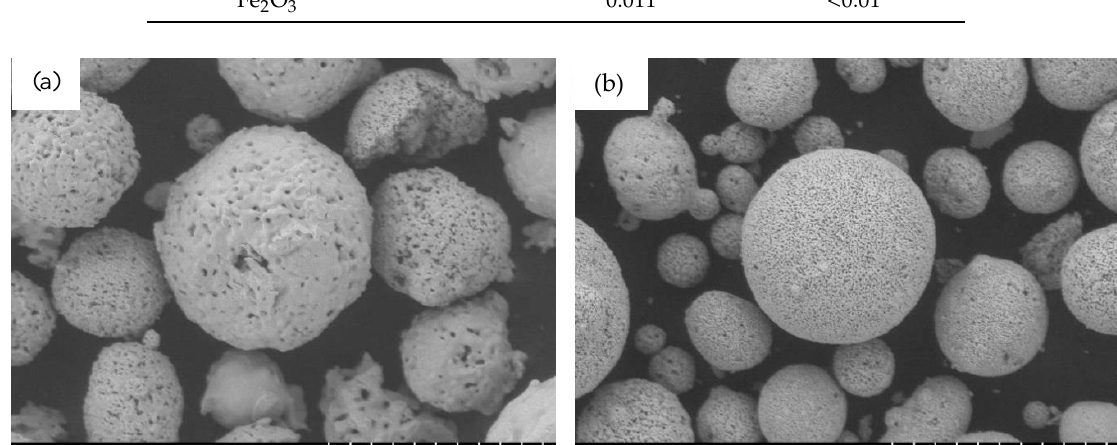
Figure 1. ( a ) SEM image of the commercial A & S spray powder; ( b ) SEM image of the experimental Low-Density A & S powder.